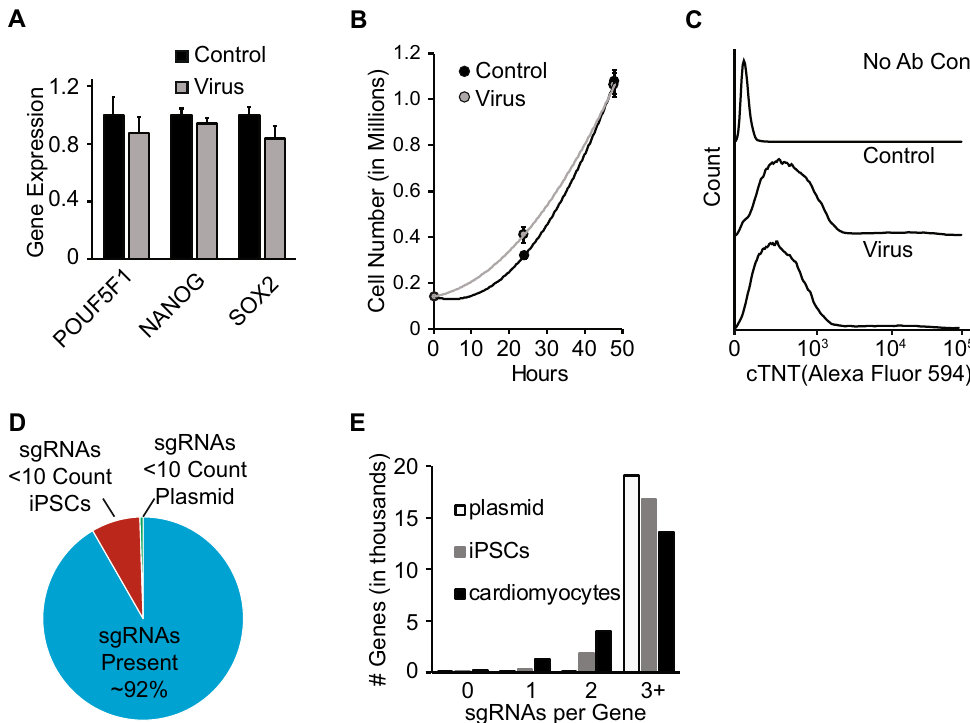
Figure2. Phenotypic resilience in pooled CRISPR/Cas9 library infected iPS cells. Uninfected iPS cells (control) or those transduced with CRISPR/Cas9 library (virus) were assessed for ( a ) gene expression of pluripotency markers (n = 3 per condition), ( b ) proliferative potential (n = 3 per condition), and ( c ) cardiac troponin T (cTNT) protein expression after differentiation to cardiomyocytes. ( d ) Percent of CRISPR/Cas9 library sgRNAs present in iPS cells at 10 read-counts or higher. ( e ) Number of sgRNAs per gene present in plasmid, iPS cells, and iPS derived